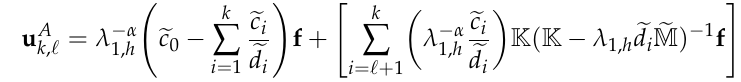
, k=45, (cid:96) = 0,2,5 ( bottom 4